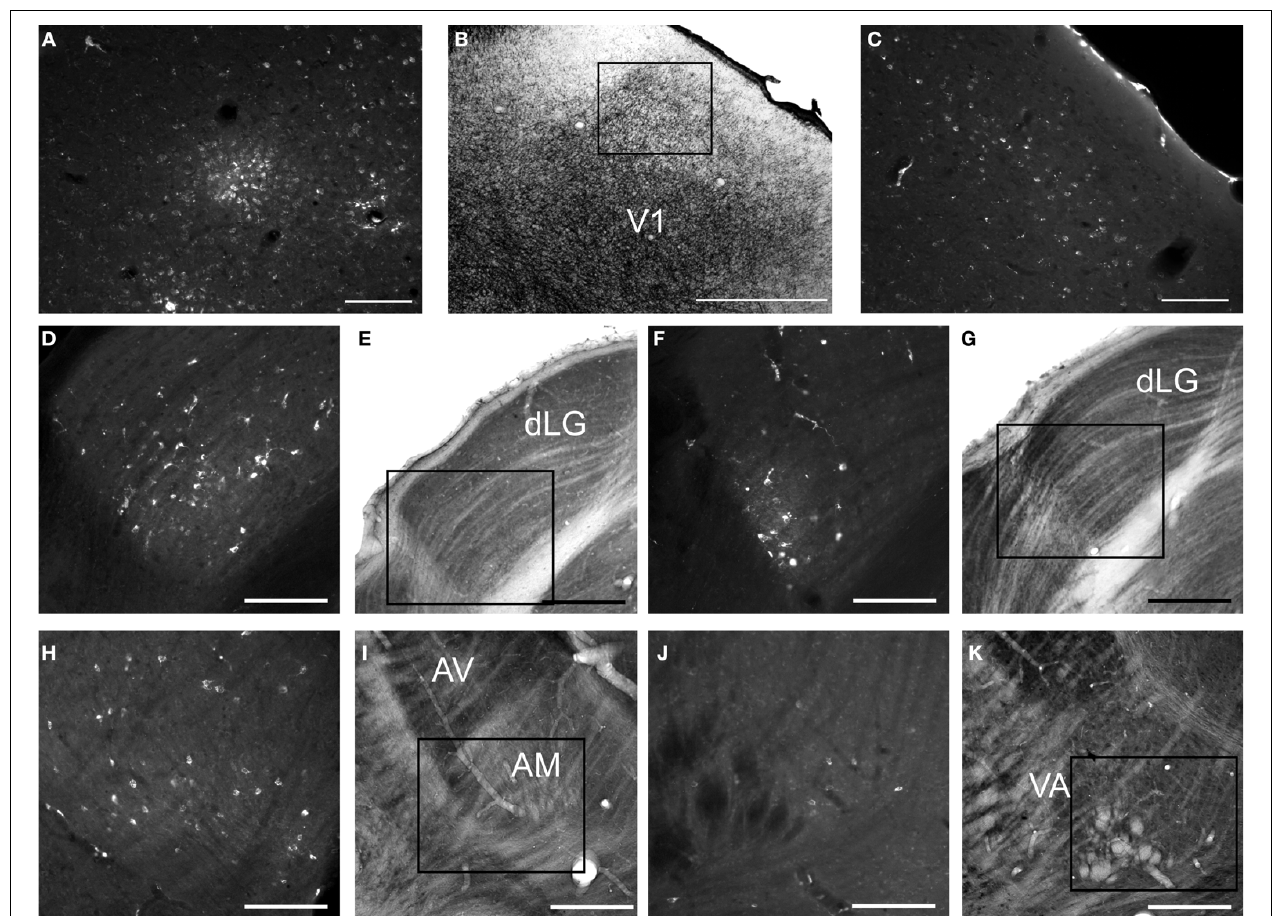
FIGURE 9 | Digital Images of Cortical and Thalamic Label in C57Bl6 and Gnat − / − Mice. Digital images of cortical and thalamic label in C57Bl6 (A,C,D) and Gnat − / − (F,H,J) mice showing retrogradely labeled cells. Adjacent myelin (B) or cytochrome oxidase (E,G,I,K) stained sections are used to defi ne the borders of specifi c cortical areas and thalamic nuclei. A representative example of an injection site of FluoroEmerald (FE) is shown in A to illustrate the restricted size of injections. The box in panel B is the area on the myelin stained section in which the injection site (A) is located. Representative examples of FE